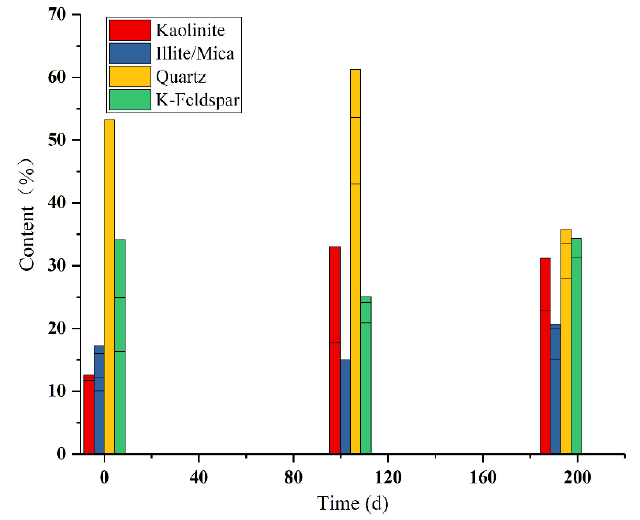
Figure 9. Clay content variation during in situ leaching, Longnan Profile.